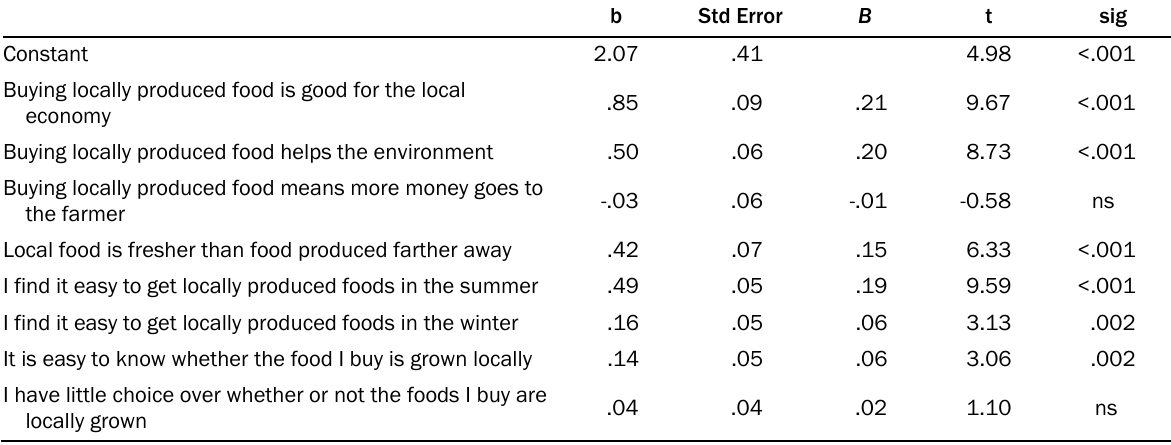
Table 7. Regression of Beliefs and Ability to Buy Locally Produced Food on Propensity to Buy Local